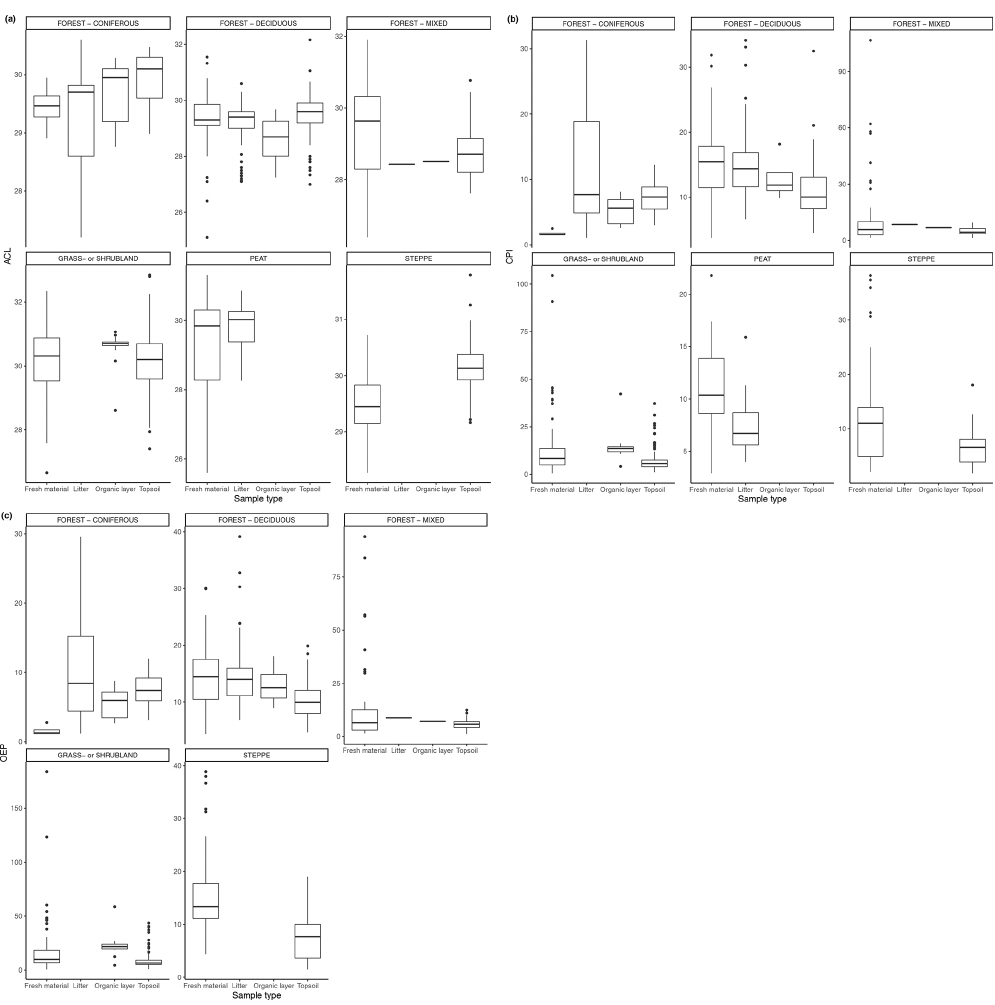
Figure 4. (a) ACL of n -alkanes in fresh leaves, litter, organic layer (litter removed), and topsoil. For the coniferous forest vegetation type, there were 13 sites included from two studies (Hirave et al., 2020; Schäfer et al., 2016). For the deciduous forest type, 41 sites were included from nine studies (Angst et al., 2016; Bliedtner et al., 2018; Bush and McInerney, 2015; Hirave et al., 2020; Lei et al., 2010; Schäfer et al., 2016; Stout, 2020; Trigui et al., 2019; Wu et al., 2019). For the mixed forest type, 26 sites were included from three studies (Bush and McInerney, 2015; Hirave et al., 2020; Howard et al., 2018). For the grassland or shrubland vegetation type, 110 sites were included from eight studies (Bliedtner et al., 2018; Bush and McInerney, 2015; Howard et al., 2018; Lemma et al., 2019; Li et al., 2018; Schäfer et al., 2016; Trigui et al., 2019; Yao et al., 2019). For the peat vegetation type, five sites were included from two studies (Ficken et al., 1998; Zhang et al., 2017). For the steppe vegetation type, 58 sites were included from three studies (Buggle et al., 2010; Struck et al., 2020; Yao et al., 2019). (b) CPI of n -alkanes in fresh leaves, litter, organic layer (litter removed), and topsoil. For the coniferous forest vegetation type, there were 13 sites included from two studies (Hirave et al., 2020; Schäfer et al., 2016). For the deciduous forest type, 42 sites were included from 10 studies (Angst et al., 2016; Bliedtner et al., 2018; Bush and McInerney, 2015; Chikaraishi and Naraoka, 2006; Hirave et al., 2020; Lei et al., 2010; Schäfer et al., 2016; Stout, 2020; Trigui et al., 2019; Wu et al., 2019). For the mixed forest type, 26 sites were included from three studies (Bush and McInerney, 2015; Hirave et al., 2020; Howard et al., 2018). For the grassland or shrubland vegetation type, 110 sites were included from eight studies (Bliedtner et al., 2018; Bush and McInerney, 2015; Howard et al., 2018; Lemma et al., 2019; Li et al., 2018; Schäfer et al., 2016; Trigui et al., 2019; Yao et al., 2019). For the peat vegetation type, five sites were included from two studies (Ficken et al., 1998; Zhang et al., 2017). For the steppe vegetation type, 57 sites were included from two studies (Struck et al., 2020; Yao et al., 2019). (c) Odd-over-even predominance (OEP) of n -alkanes in fresh leaves, litter, and topsoil. For the coniferous forest vegetation type, there were 13 sites included from two studies (Hirave et al., 2020; Schäfer et al., 2016). For the deciduous forest type, 44 sites were included from nine studies (Angst et al., 2016; Anokhina et al., 2018; Bliedtner et al., 2018; Bush and McInerney, 2015; Hirave et al., 2020; Schäfer et al., 2016; Stout, 2020; Trigui et al., 2019; Wu et al., 2019). For the mixed forest type, 26 sites were included from three studies (Bush and McInerney, 2015; Hirave et al., 2020; Howard et al., 2018). For the grassland or shrubland vegetation type, 105 sites were included from seven studies (Bliedtner et al., 2018; Bush and McInerney, 2015; Howard et al., 2018; Lemma et al., 2019; Li et al., 2018; Schäfer et al., 2016; Trigui et al., 2019). For the steppe vegetation type, 52 sites were included from one study (Struck et al., 2020).